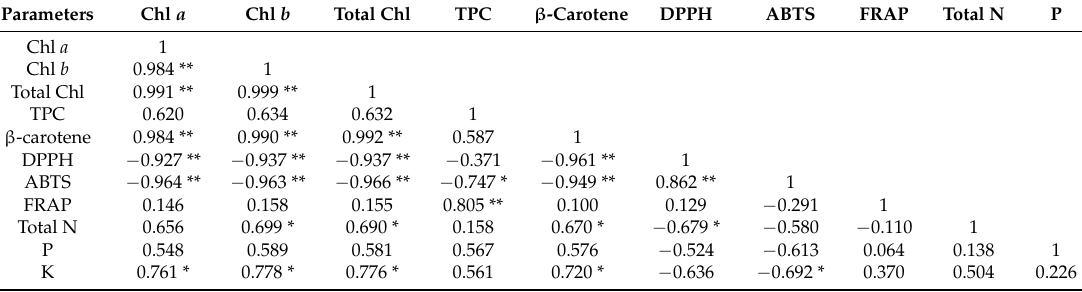
Table 4. Pearson’s correlation coefficient between bioactive compounds composition and antioxidant capacities of fruit extract and NPK content in the D-leaves of MD2 pineapple plant during the emergence of the